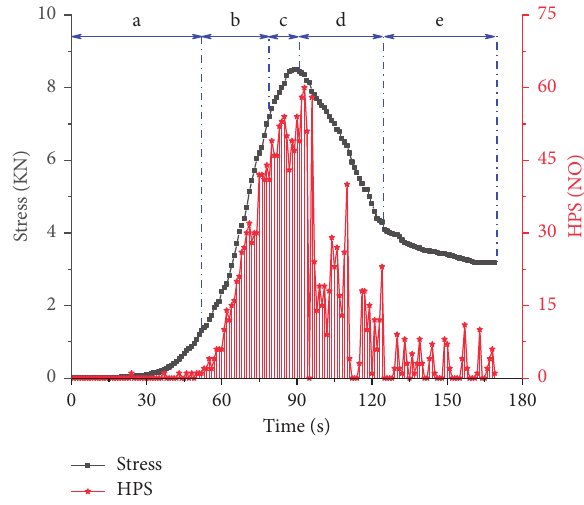
Figure 5: The stress-time curve and AE HPS-time curve of backfill under uniaxial compression.